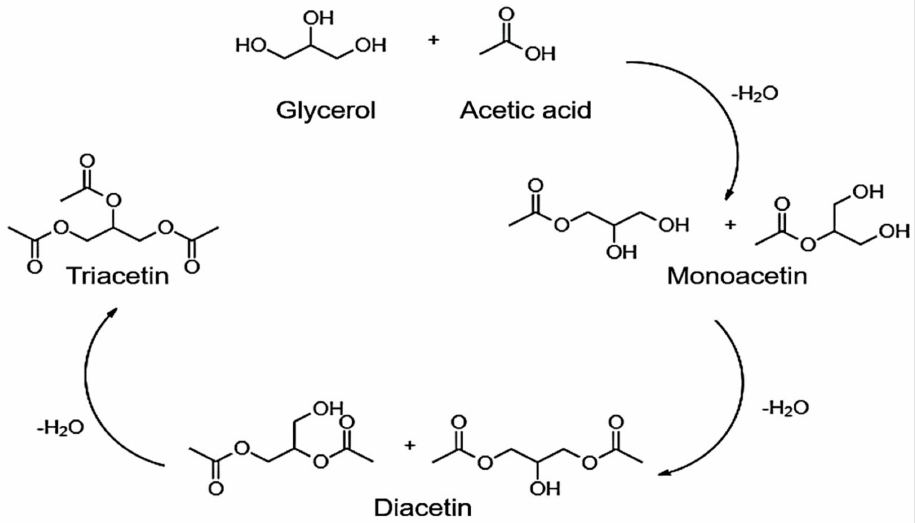
Figure 1. Reaction pathway of acetylation of glycerol with acetic